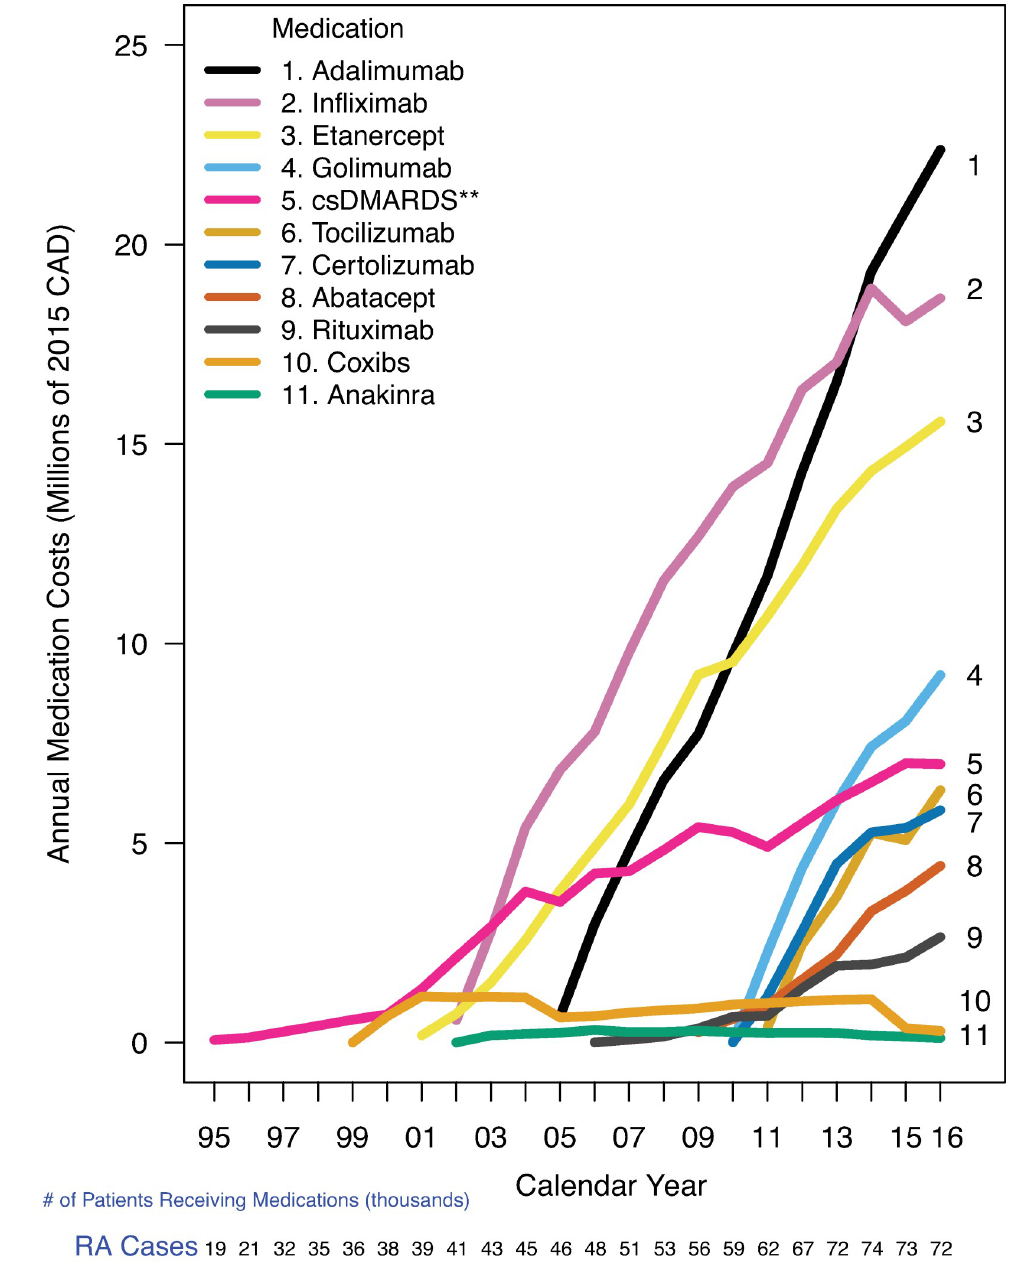
Fig 7. Annual RA medication costs over time. X-axis: Calendar year, Y-axis: Annual Medication Costs (Millions of 2015 CAD), Grouping Variable: Medication).